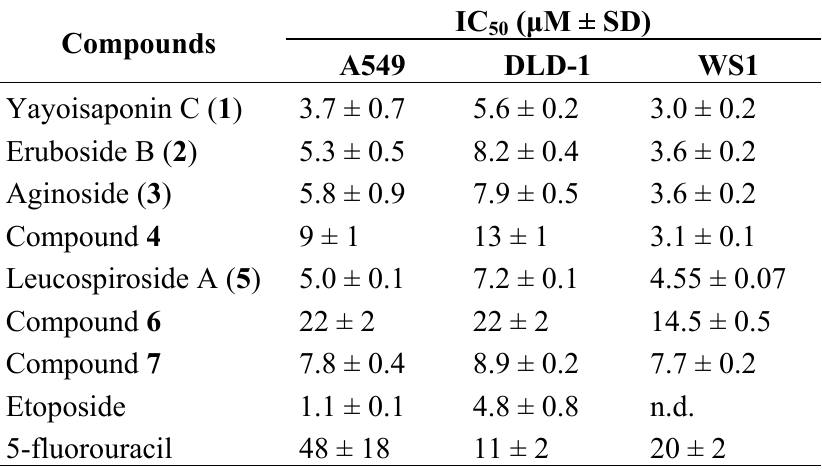
Table 4: Cytotoxicity of saponins and genins from A.